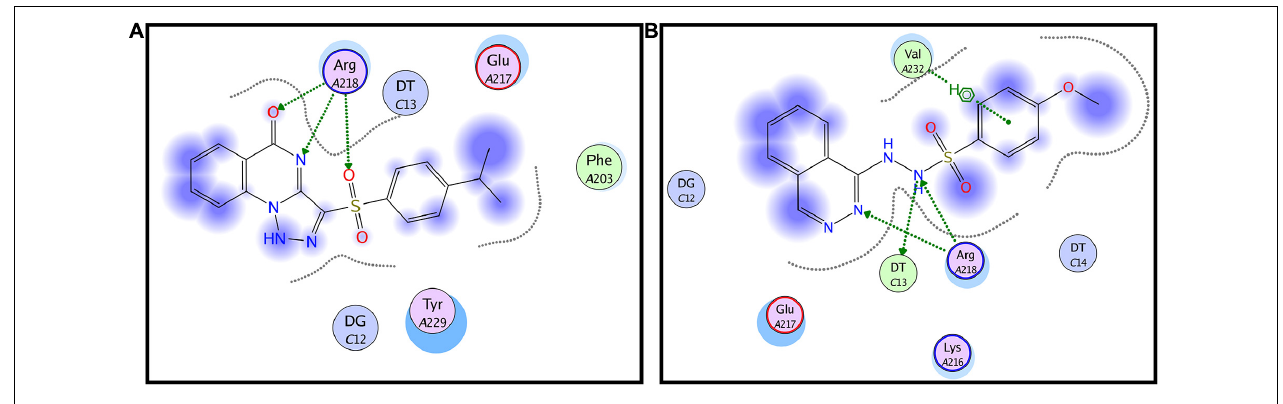
FIGURE 3 | In silico docking of both savirin and staquorsin to the S. aureus AgrA. Two-dimensional diagrams of savirin (A) and staquorsin (B) docking pose interactions with the key amino acids in the AgrA binding site. The blue regions denote an area that can form hydrophobic interactions. Dotted arrows denote the formation of H bonds from the donor to the acceptor atoms. The diagrams were generated using the Molecular Operating Environment (MOE, 10.2008) software.